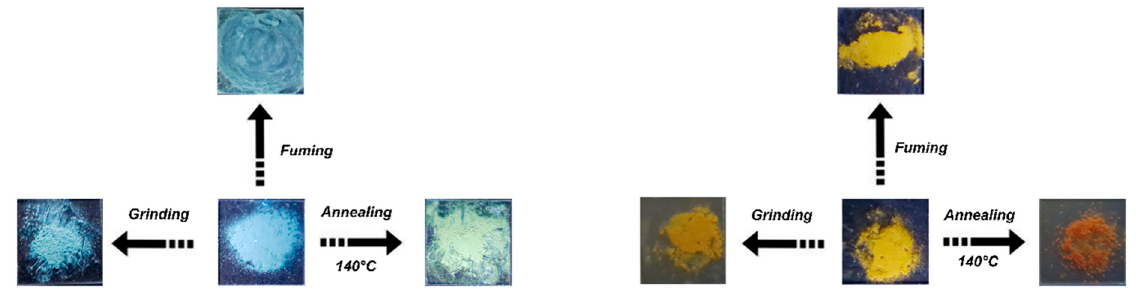
Figure 4. A sample of as-synthetized Ac1 (on the left ) and Ac2 (on the right ), photographed after grinding, solvent fuming (acetone) and heating process.